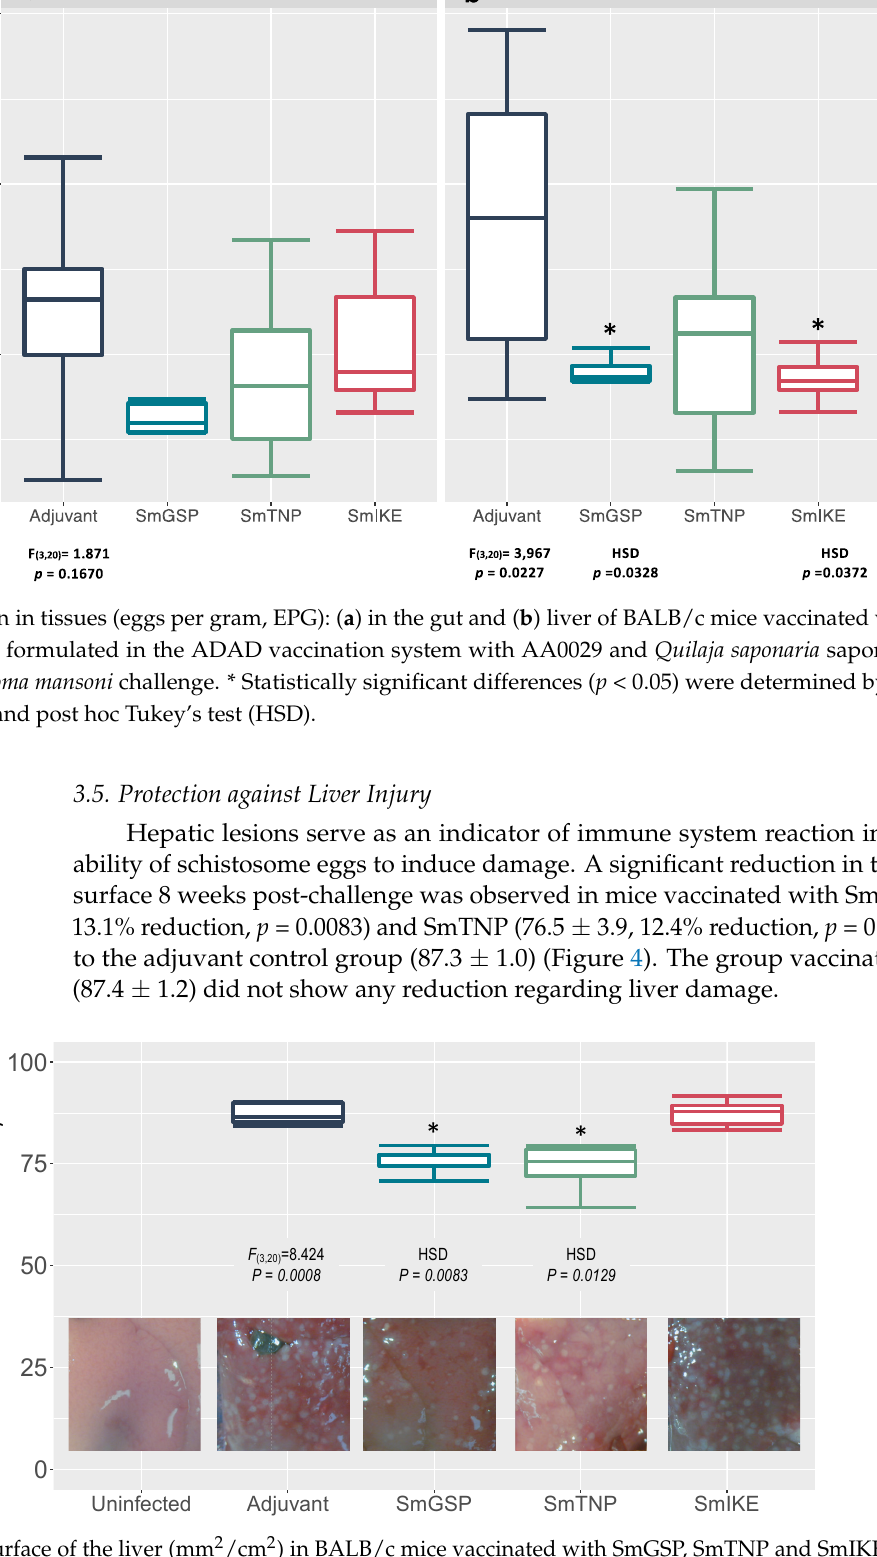
Figure 4. Affected surface of the liver (mm 2 /cm 2 ) in BALB/c mice vaccinated with SmGSP, SmTNP and SmIKE formulated in the ADAD vaccination system with AA0029 and Quillaja saponaria saponins at eight weeks post- S. mansoni challenge. * Statistically significant differences ( p < 0.05) were determined with analysis of variance (ANOVA) and post hoc Tukey’s test (HSD).